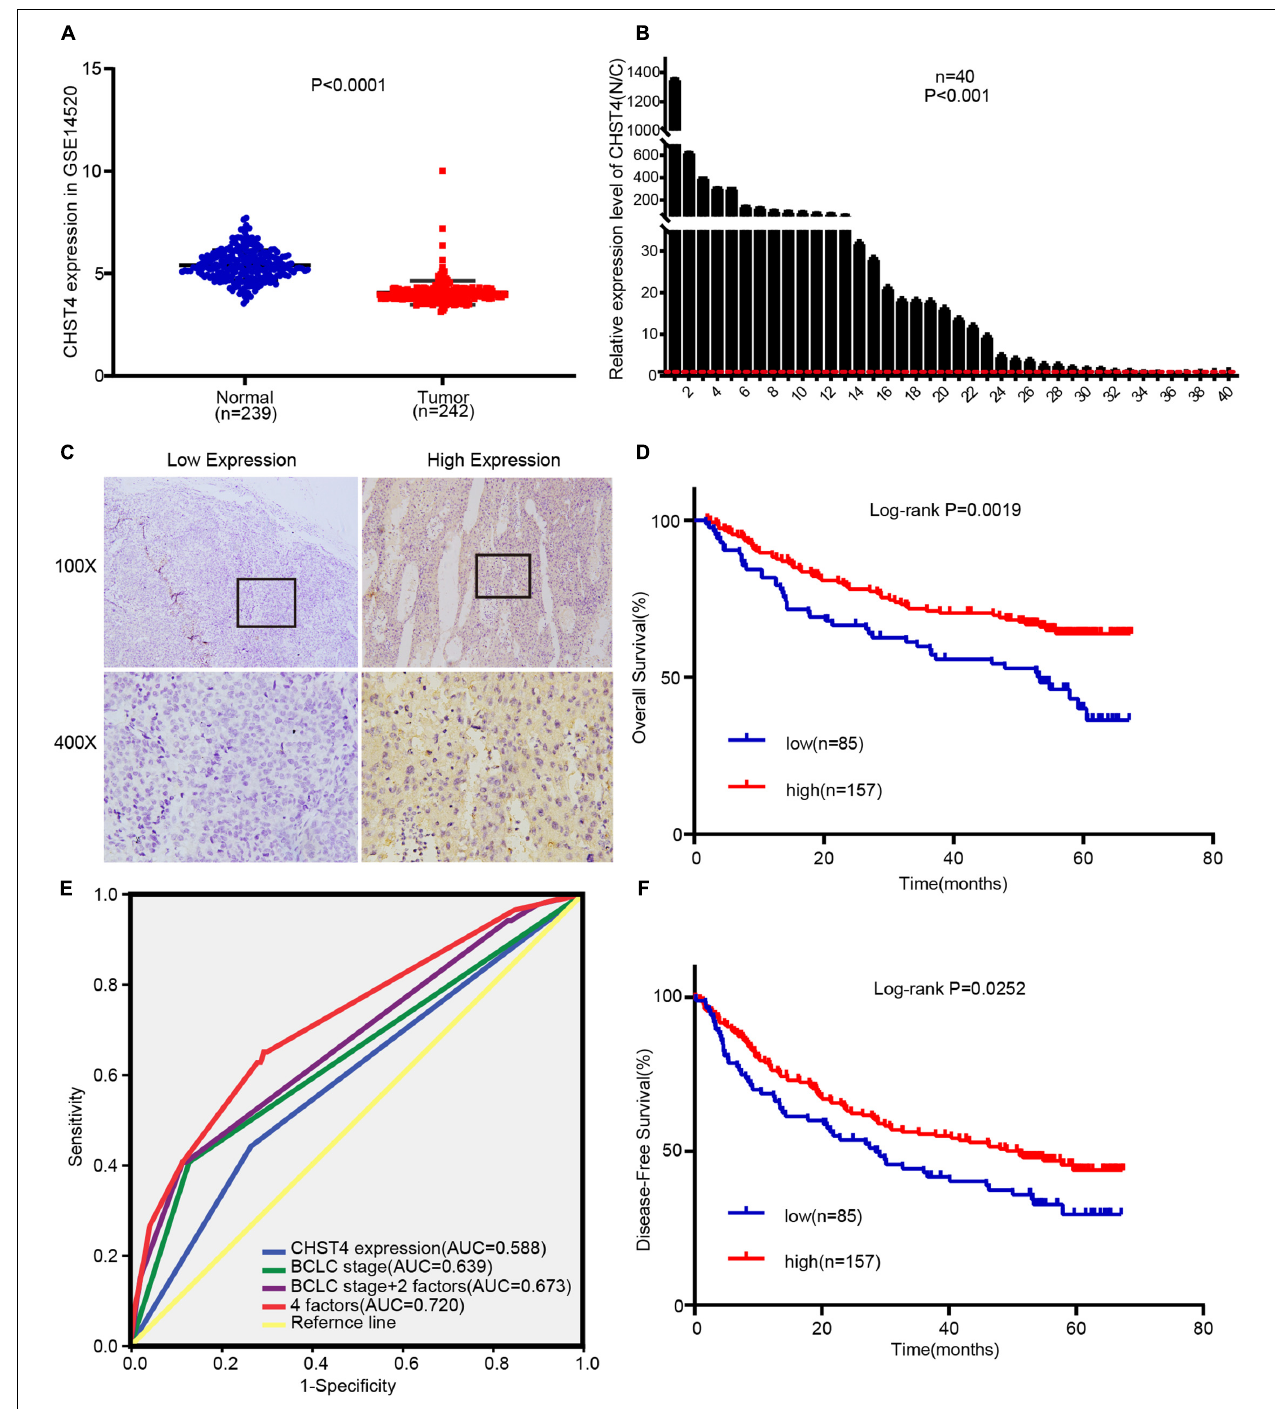
FIGURE 4 | High CHST4 expression is related to better prognoses in patients with hepatitis B virus-related hepatocellular carcinoma (HBV-HCC). (A) Expression of CHST4 in patients from the GSE14520 dataset. (B) mRNA expression of CHST4 in 40 paired HCC and normal tissue samples (N/C) by qRT-PCR assays. All samples were tested in triplicate. The statistical analysis is paired-samples t-test. Bars represent the mean ± SD. (C) Representative staining of low and high CHST4 expression in the tumor cell cytoplasm. (D,F) . Kaplan–Meier analysis of overall survival and disease-free survival in those with high CHST4 expression in the GSE14520 dataset versus low expression. (E) Receiver-operating characteristic curves (ROC) of the prognostic accuracy of CHST4 expression and clinicopathological risk factors of patients in the GSE14520 dataset. Comparative ROC curves for CHST4 expression, Barcelona Clinic Liver Cancer (BCLC) stage, and BCLC stage with two factors (multinodular and cirrhosis) or with four factors (CHST4 expression, BCLC stage, multinodular, and cirrhosis) are shown (AUC, area under the curve).